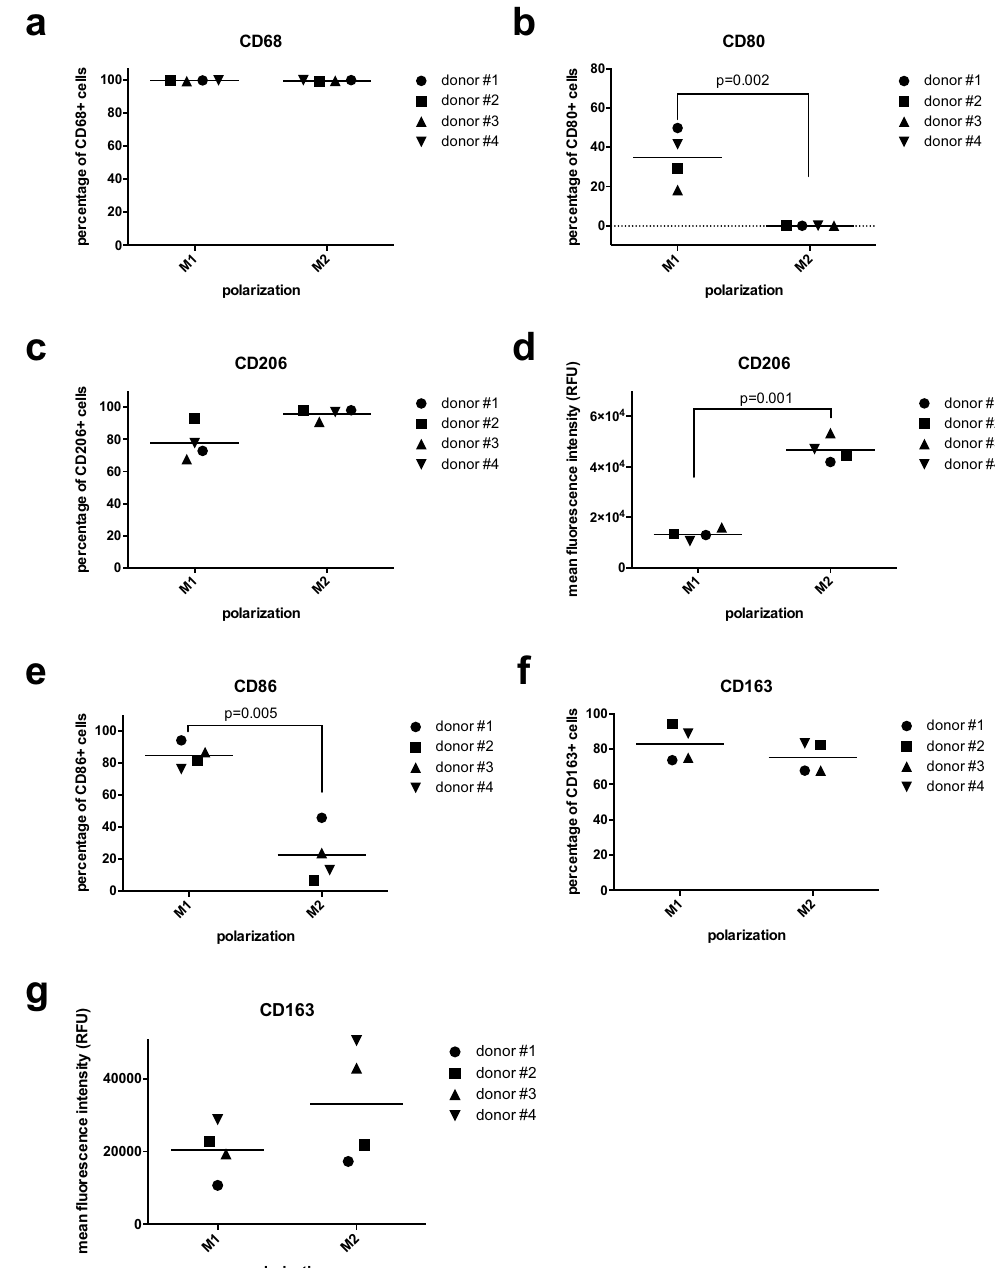
Figure 3. Flow cytometry. ( a – c ) Positivity to pan-macrophagic marker CD68 ( a ), M1 marker CD80 ( b ) and M2 marker CD206 ( c ). ( d ) Mean fluorescence intensity levels for CD206. ( e , f ) Positivity to M1 marker CD86 ( e ) and M2 marker CD163 ( f ). ( g ) Mean fluorescence intensity levels for